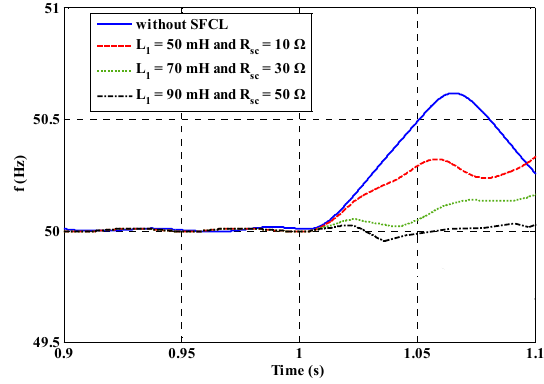
Figure 19. Frequency fluctuations of the micro ‐ grid under the internal fault.